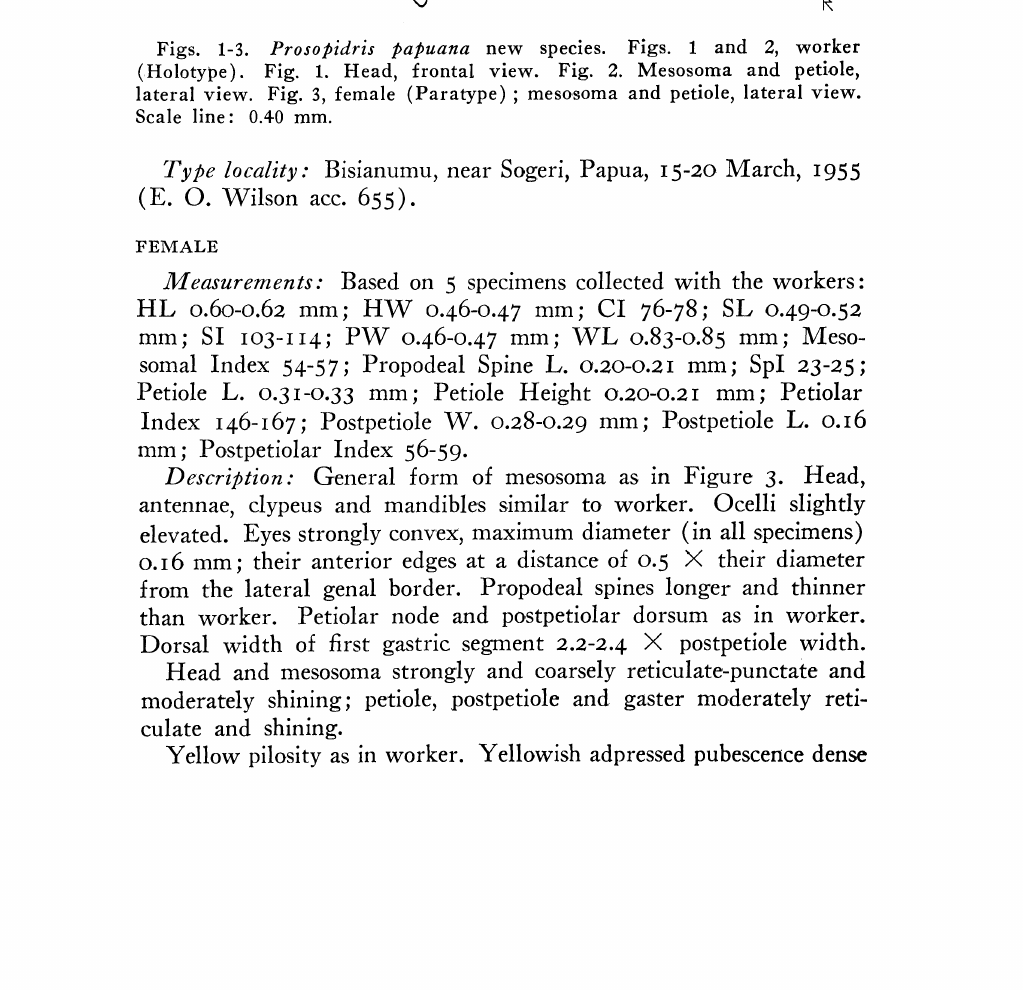
Figs. 1-3. Prosopidris papuana new species. Figs. and 2, worker (.Holotype). Fig. 1. Head, trontal view. Fig. 2. Mesosoma and petiole, lateral view. Fig. 3, female (Paratype) mesosoma and petiole, lateral view. Scale line: 0.40